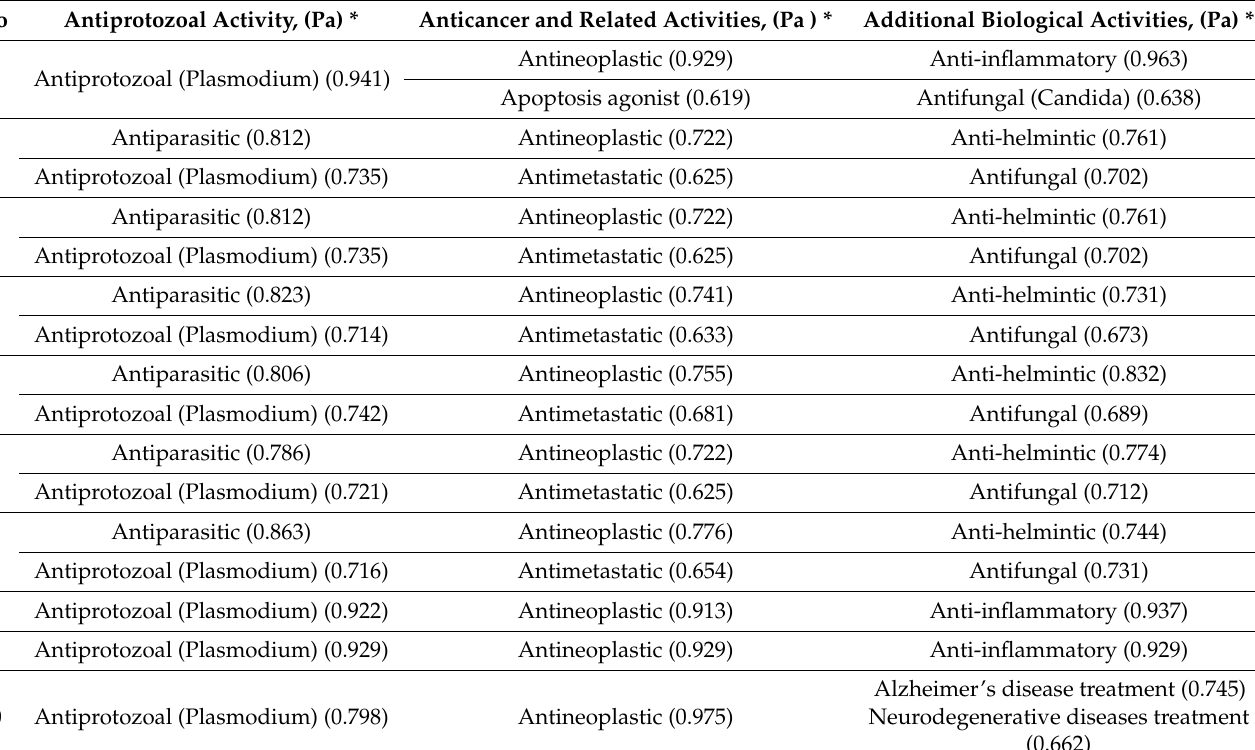
Table 1. Biological activity of natural polycyclic peroxides derived from marine